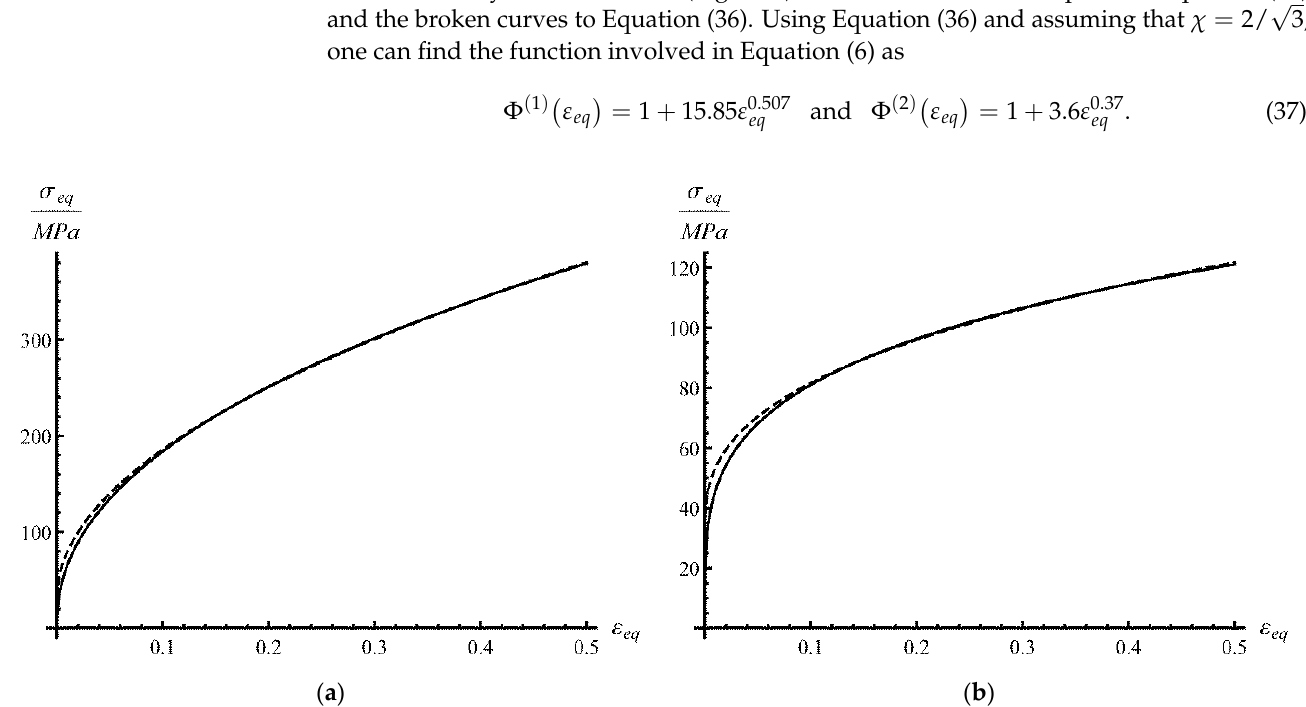
Figure 2. Stress–strain curves according to Equations (35) and (36): ( a ) copper alloy, ( b ) aluminum alloy. The solid curves correspond to Equation (35) and the broken curves to Equation (36).